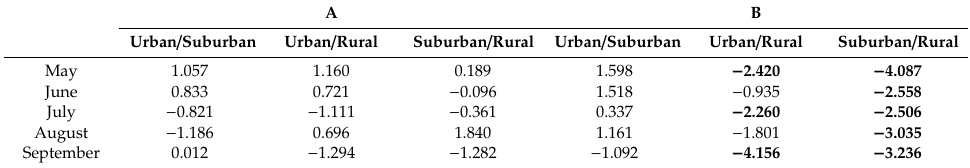
Table 7. Paired t-test for the statistical significance between A i .A j and B i .B j (for t values greater than 1.96, the di ff erences were statistically significant for α =